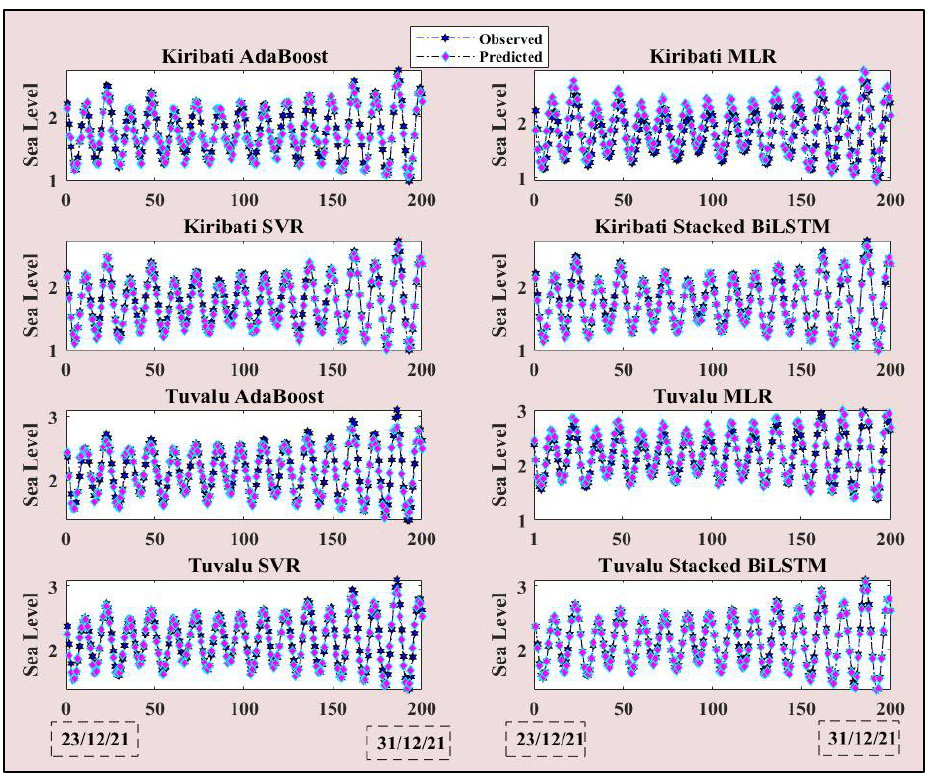
Figure 17. Time series comparison of observed and predicted values of 200 data points for a duration from 23/12/21 to 31/12/21.